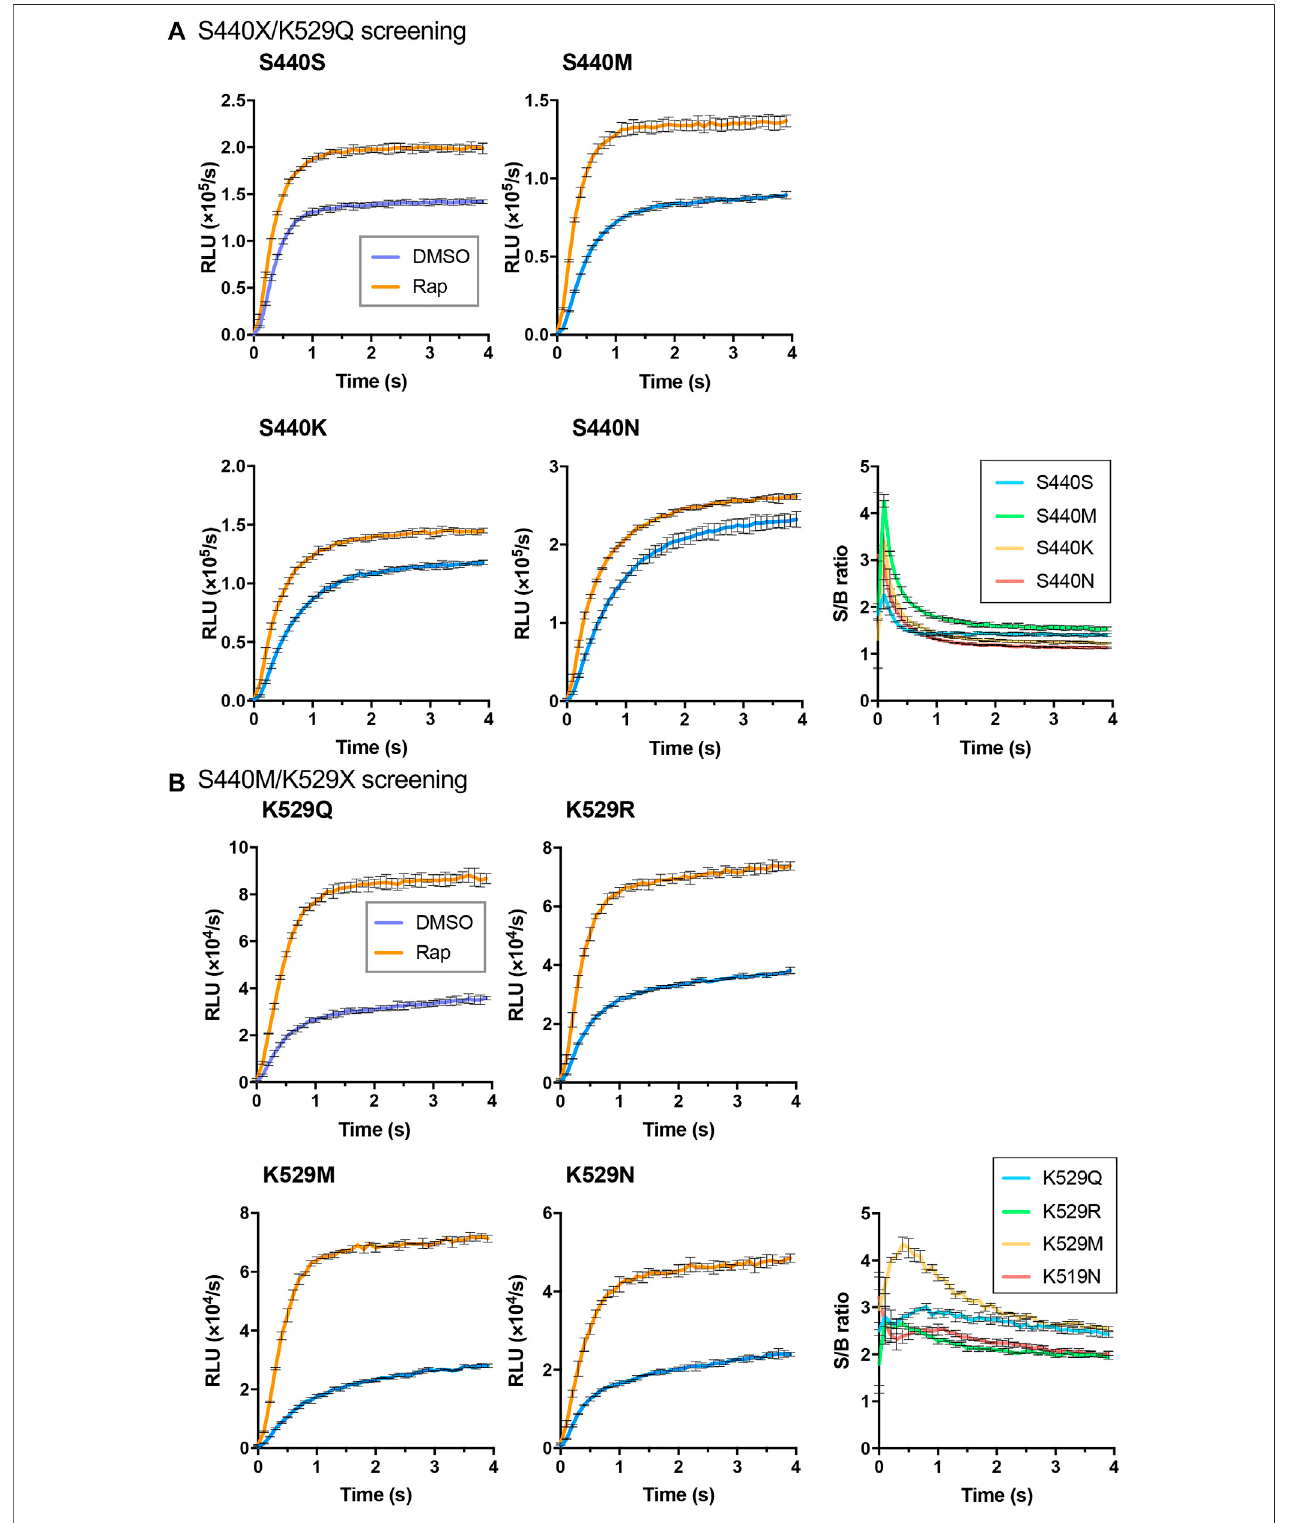
FIGURE 2 | Screening of LlL Acceptors. (A) S440X/K529Q screening. (B) S440M/K529X screening. Error bar: ± 1 × SD ( n (cid:2) 3). Ppy Donor (50 nM) and each candidate of LlL Acceptor (50 nM) were reacted with ATP (10 mM) and LH 2 (37.5 μ M) with/without rapamycin (Rap) (50 nM).